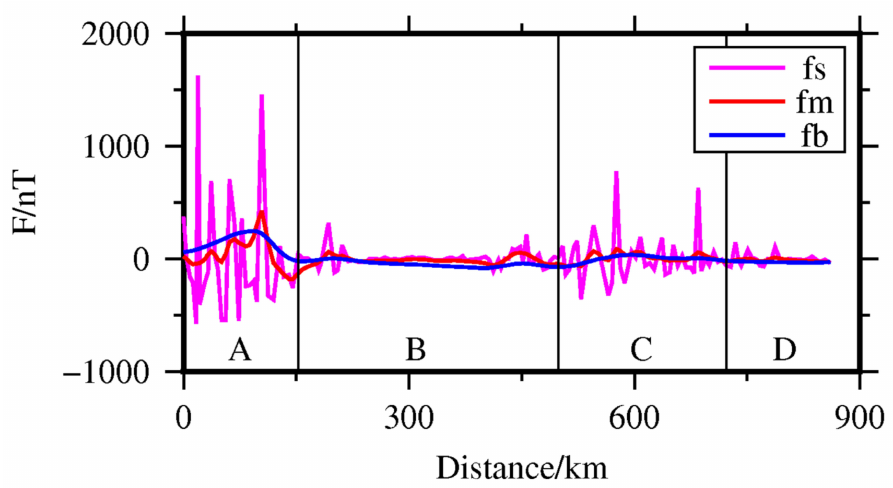
Figure 3. Decomposition results of the lithospheric magnetic field: basement part f b , middle part f m , and surficial part f s